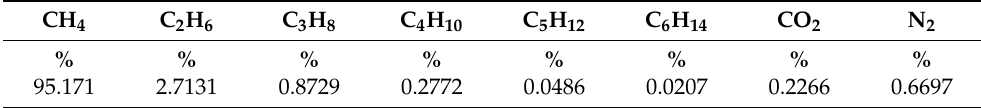
Table 3. Natural gas composition in % vol. (adapted from